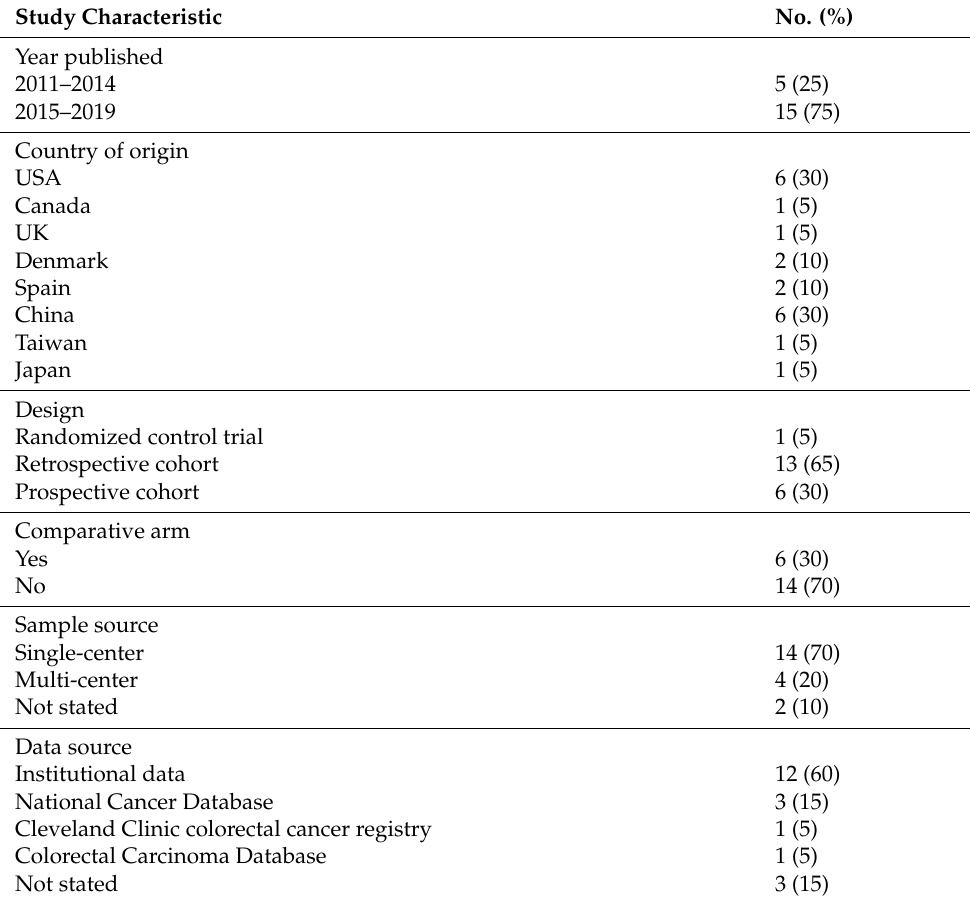
Table 1. Selected study characteristics of included articles (n =